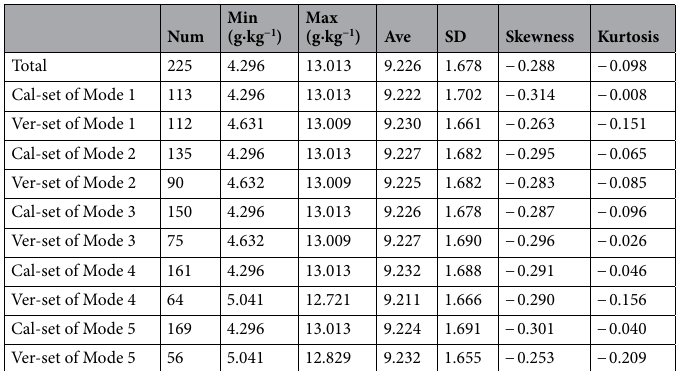
Table 2. Descriptive statistical analysis of test samples. Num, Min, Max, Ave, SD, Cal-set, and Ver-set are number, minimum, maximum, average, standard deviation of samples, calibration set, and verification set, respectively.